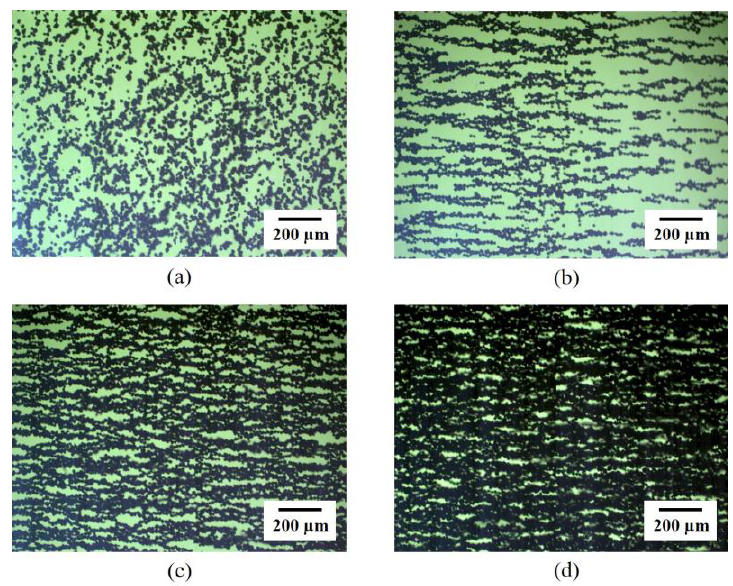
Figure 4. Illustration of particle alignment process in the pre-polymer state: ( a ) Without magnetic field; ( b ) Magnetic field with short magnetization time; and ( c ) Magnetic field with long magnetization time.